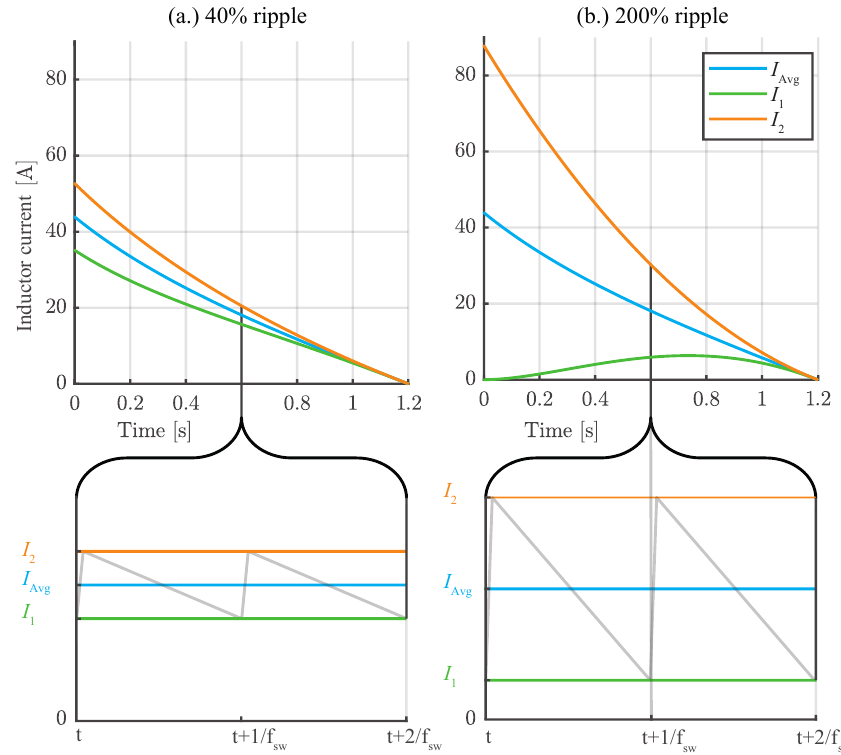
Figure 15. Boost and PP Boost super-capacitor inductor ( L SC ) current and ripple envelope during energy recovery braking process for two different initial voltage ripples, ( a ) 40% and ( b ) 200%, based on a 48 V super-capacitor